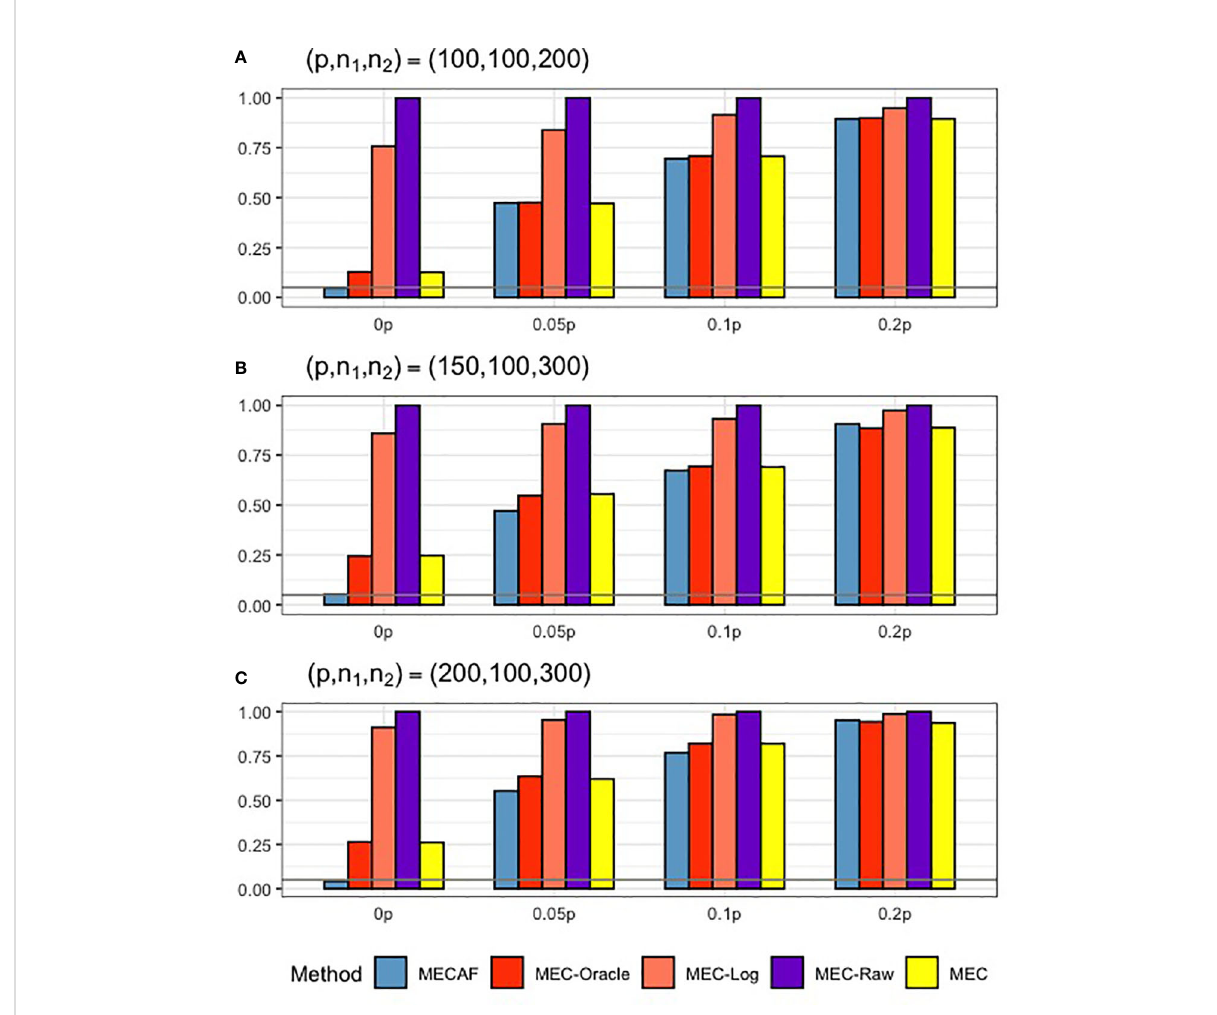
FIGURE 1 Simulation results for Scenario 1: unequal covariance matrices between compared groups. The empirical type I error rate (H_0: 0p) and statistical power under three sparsity measures ( H a :0.05 p , 0.1 p , and 0.2 p ) for MECAF and competing methods MEC-Oracle, MEC-Log, MEC- Raw, and MEC. A horizontal line with a = 0.05 indicates the signi fi cance level. The number of taxa and sample sizes were set as follows: (A) ( p , n 1 , n 2 ) = (100,100,200); (B) ( p , n 1 , n 2 ) = (150,100,300); (C) ( p , n 1 , n 2 ) =